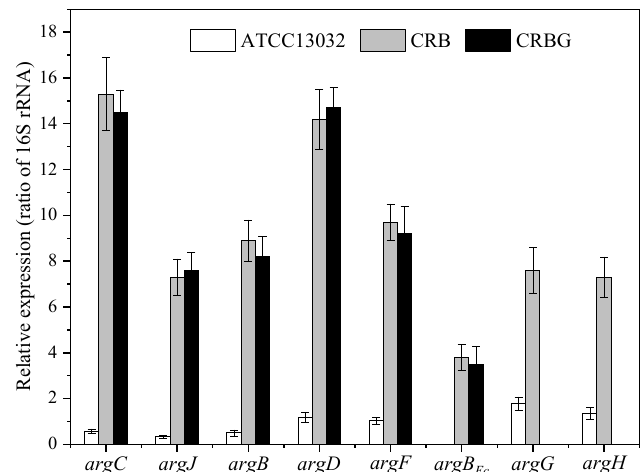
Figure 2. Transcriptional analysis of genes involved in L-citrulline and L-arginine biosynthesis. The expression levels of the genes were calculated as the ratio of 16S rRNA expression level. The error bars represent the standard deviation of three independent replicates.